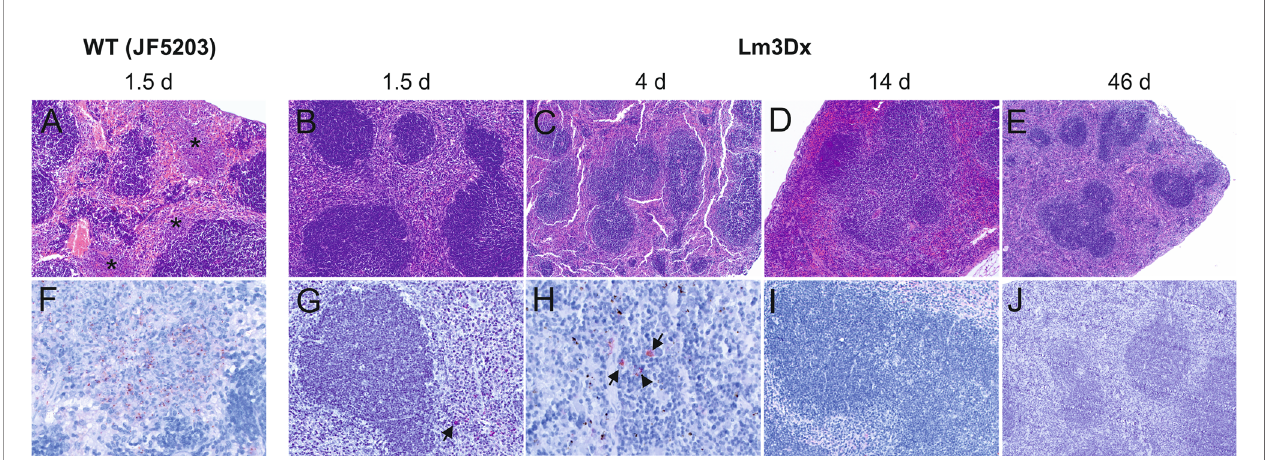
FIGURE 6 | Representative HE (A – E) and immunohistochemically (antibody against Lm) (F – J) stained spleen tissue of WT- and Lm3Dx_SAG1- injected mice. (A) Coalescing necrosuppurative foci in the red pulp of the spleen (asterisks) in mice at 36h following injection with WT Lm (100x magni fi cation). (B – E) Spleens of mice injected with 1 x 10 7 Lm3Dx_SAG1 are normal, without lesions of necrosuppurative splenitis at all time points: (B) 1.5d (100x magni fi cation) and (C) 4d (40x magni fi cation) following inoculation, (D) 14d (40x magni fi cation) and (E) 46d (40x magni fi cation) following the second boost injection. (F) Necrosuppurative foci contain numerous bacteria at 1.5d following inoculation with WT Lm (400x magni fi cation). (G) At 1.5d following Lm3Dx_SAG1 injection, 4/5 mice contained multifocal in fl ammatory cells of the splenic red pulp with a positive Lm signal (arrow), but no clear bacterial structures were observed (200x magni fi cation). (H) At 4d following Lm3Dx_SAG1 injection, 4/7 lactating mice contained multifocal in fl ammatory cells of the splenic red pulp with a positive Lm signal (arrows), and additionally elongated positive structures compatible with bacteria (400x magni fi cation). (I) At 14d (200x magni fi cation) and (E) 46d (100x magni fi cation) following the second boost injection, no positive signal was observed in Lm3Dx_SAG1 injected mice.